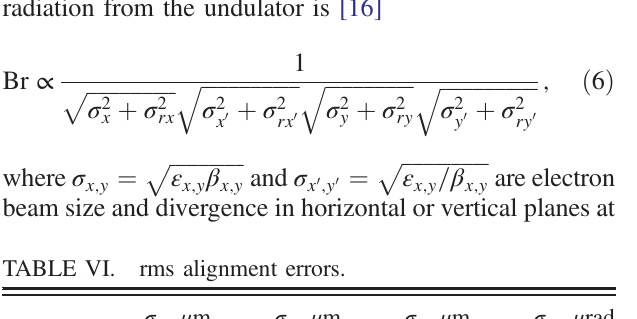
FIG. 19. Tune dependance on initial amplitudes: the tune ν x ð ν y Þ is plotted along the vertical axis, one of the initial coordinate x ð y Þ is plotted along the horizontal axis, while the colors represent the other coordinate y ð x Þ .